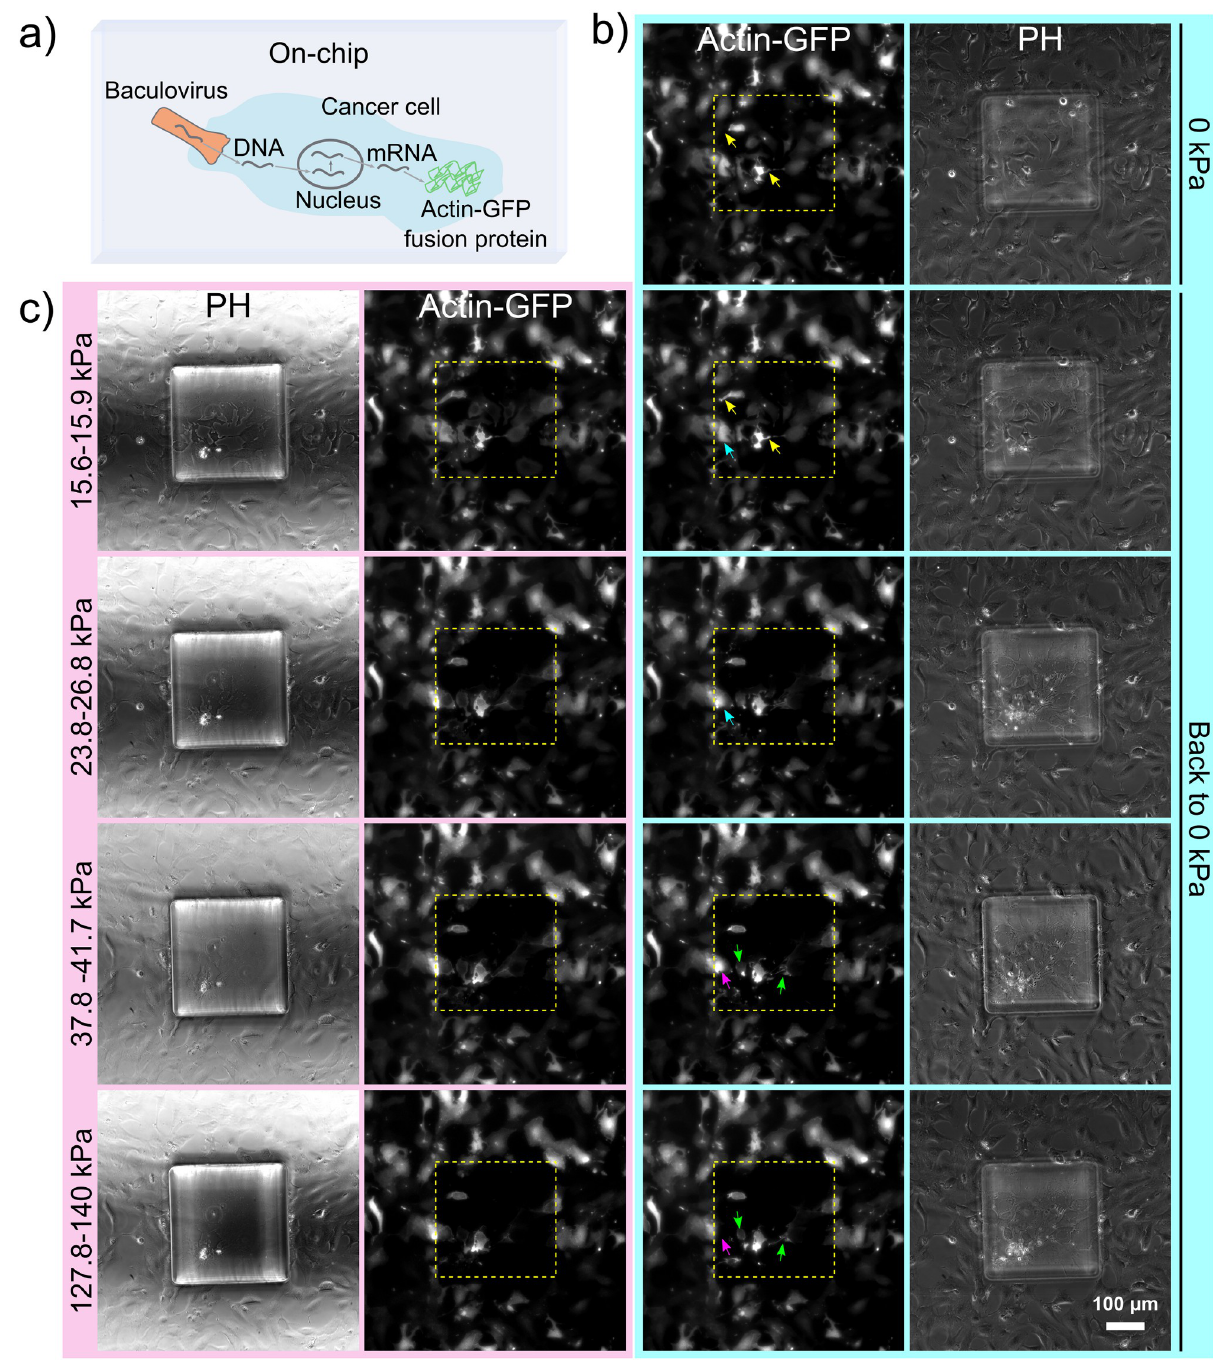
Fig 3. Representative fluorescent microscopy images of live imaging of GFP-tagged actin cytoskeleton of cells. (a) Schematic of the on-chip BacMam transduction into cancer cells for the expression of actin-GFP fusion protein. (b) Phase contrast (right) and fluorescent (left) images of the GFP-tagged actin expressing SKOV-3 ovarian cancer cells in static state (0 kPa) or retracted back to static state (0 kPa) after compression for the given pressure range. Yellow arrows indicate example cells exhibiting rearrangement of actin structures with formation of new extensions, blue arrows for actin deformation with rearrangement of existing actin structures, green arrows for actin disruption with raptures and pink arrows for complete actin disruption. (c) Phase contrast (left) and fluorescent (right) images showing the change in GFP-tagged actin in the cells as a result of the applied pressure in the compressed state. Pressure was applied sequentially in ascending